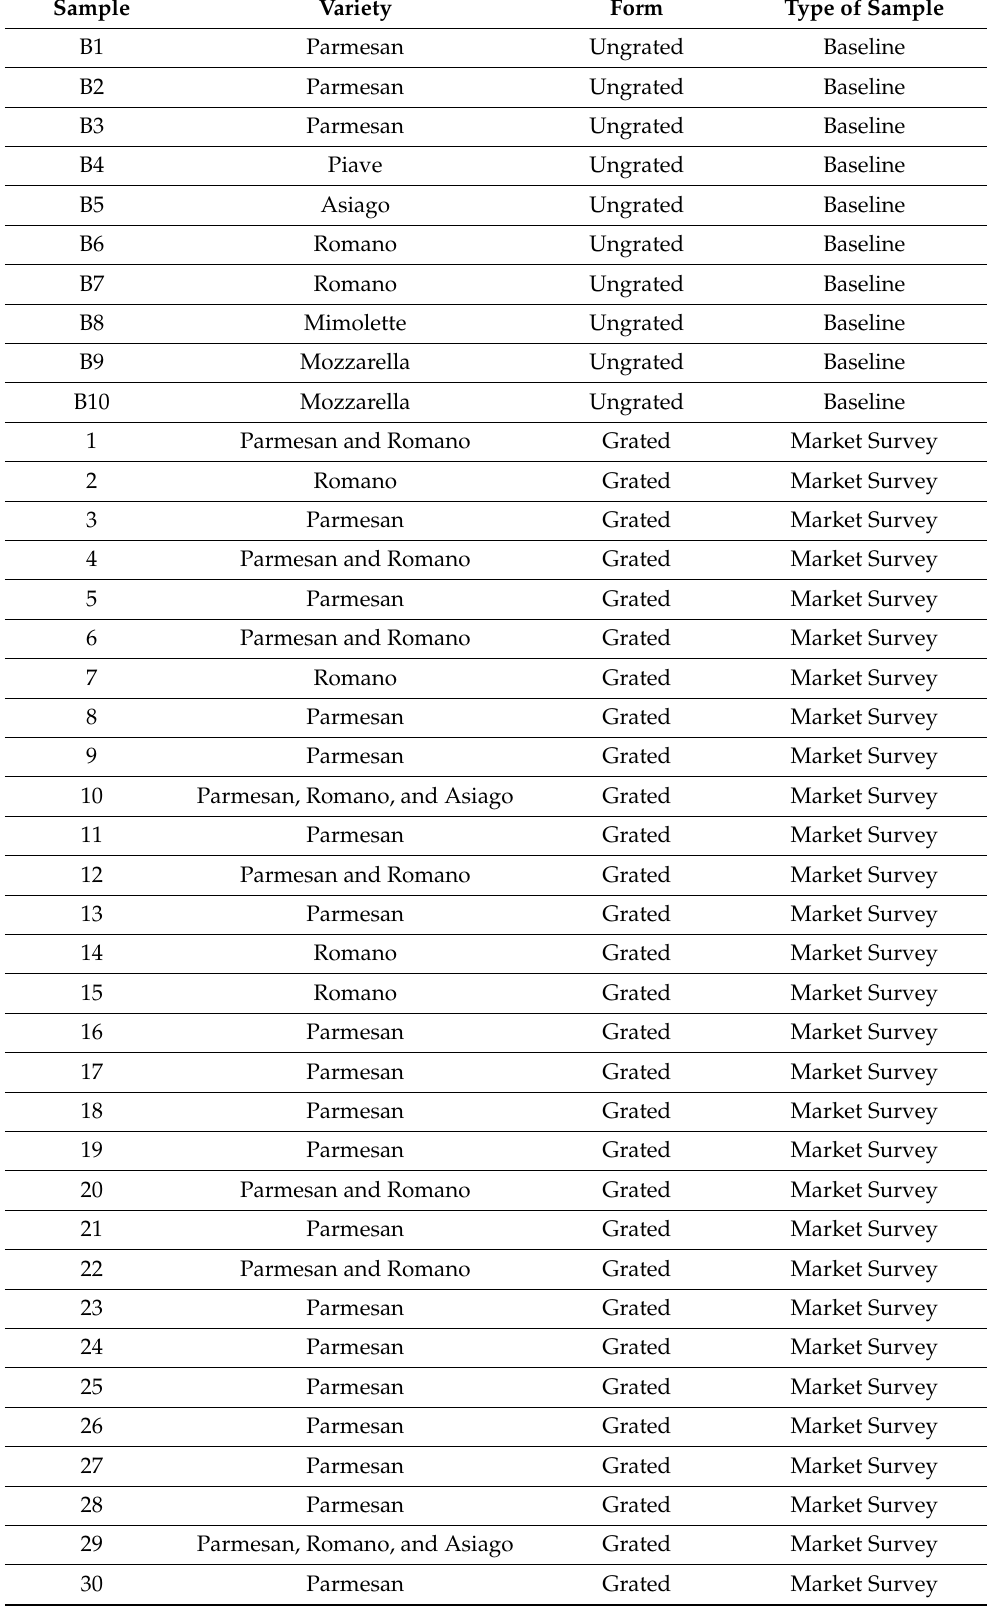
Table 4. List of all cheese samples analyzed in this